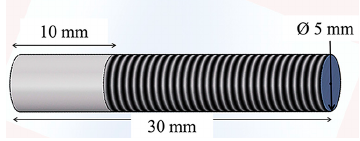
Figure 2 . Dimensions of the threaded rivet (M5) used in this work.